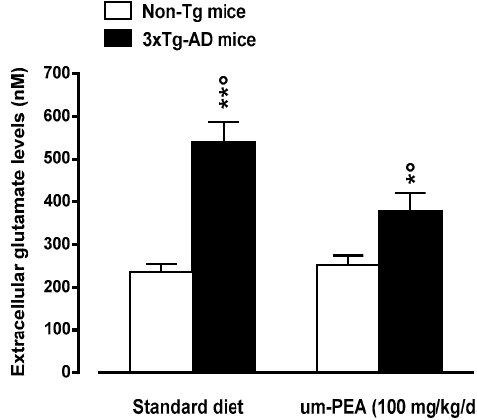
Figure 7. Oral ultramicronized palmitoylethanolamide (um-PEA) treatment rescues increased glutamate levels in the hippocampus of 3×Tg-AD mice. Age-matched non-Tg mice and 3×Tg-AD mice (2 months ± 2 weeks of age) have been orally treated for 3 months with the compound (100 mg/kg/day, added to the animal food), while control animals were fed with a standard diet during the treatment period. Microdialysis experiments were performed at the end of the treatment period. The data are presented as mean ± SEM of 6–7 animals/group. * p < 0.05, ** p < 0.01 significantly different from the respective non-Tg mouse group; p < 0.05 significantly different from the respective PEA-treated group according to two-way ANOVA followed by Tukey multiple-comparison test.